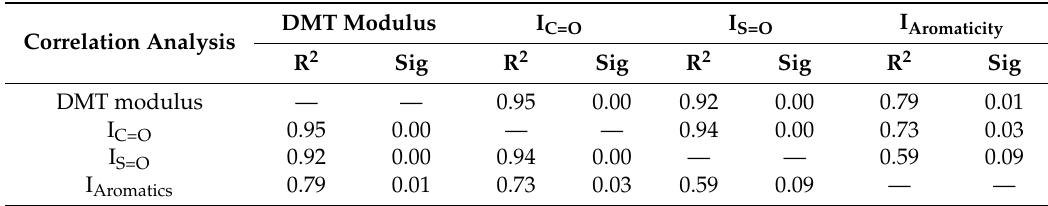
Table 5. Correlation